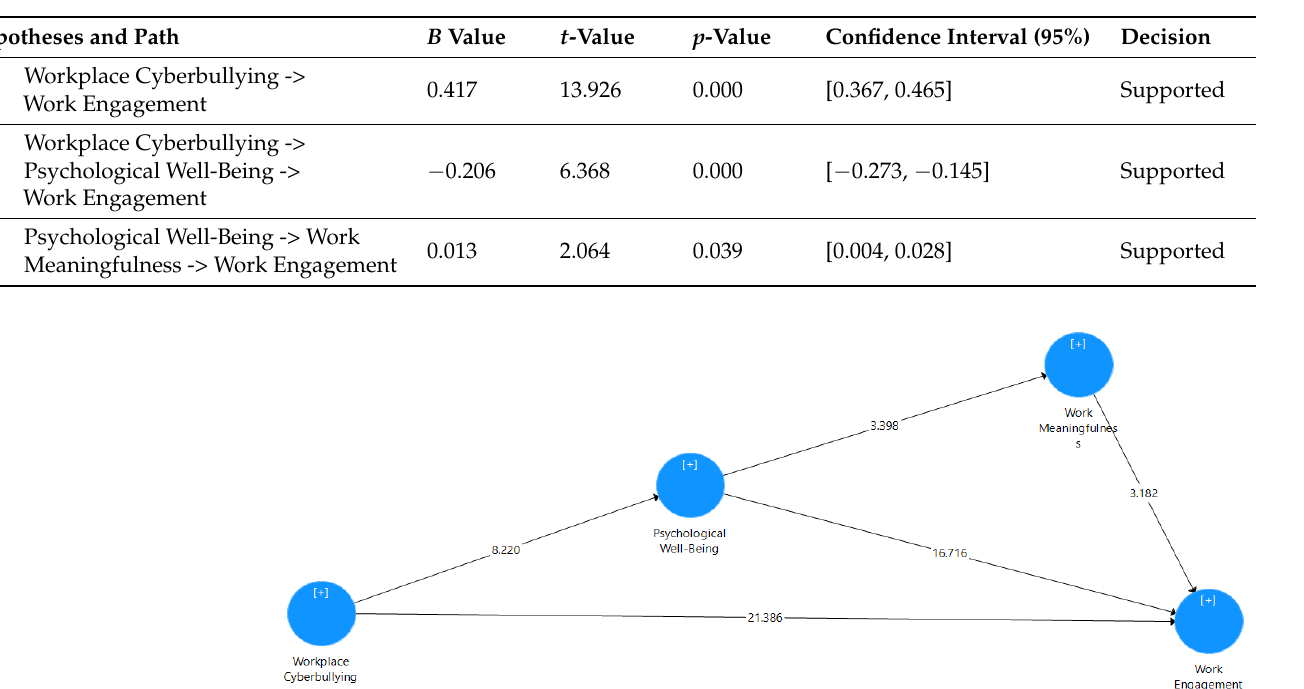
Table 4. Direct and indirect path.